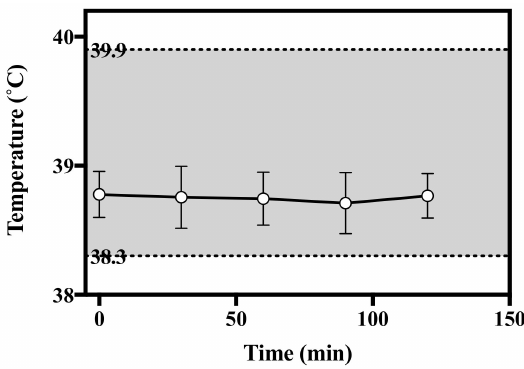
Figure 11. Change of temperature after the application of HBsAg MN in rabbits. Grey shade represents the normal temperature of